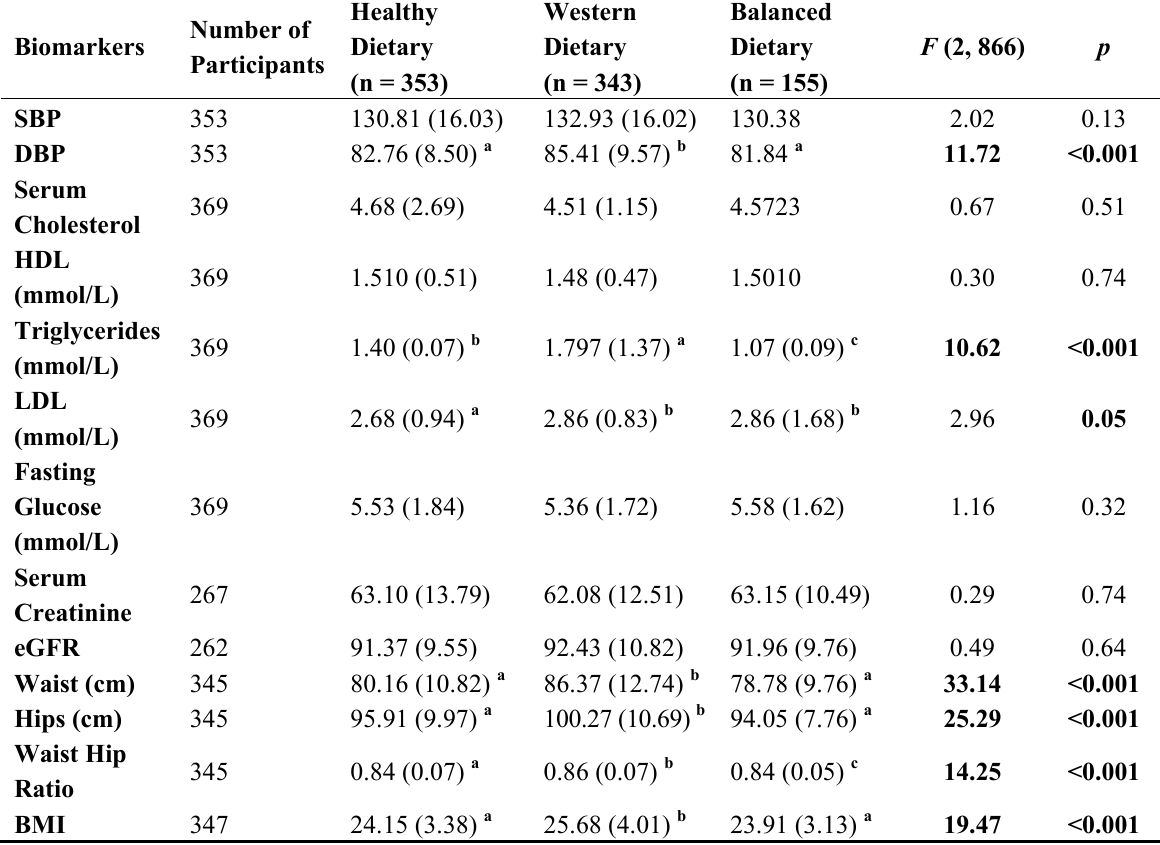
Table 5. Association between dietary patterns and chronic disease related risk factors.